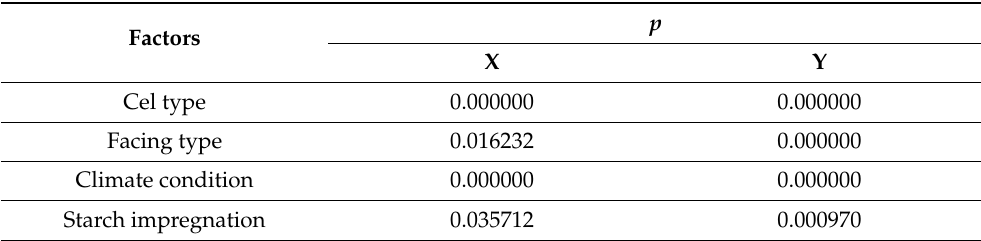
Table 6. The significance of the influence of individual factors on the principal components for the directions of X and Y orthotropy.